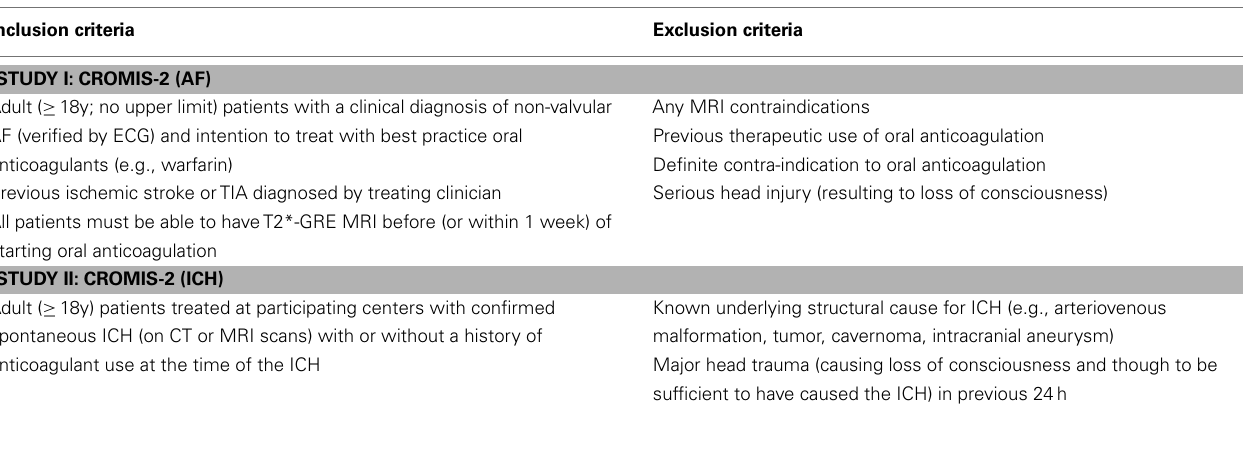
Table 4 | CROMIS-2 inclusion and exclusion